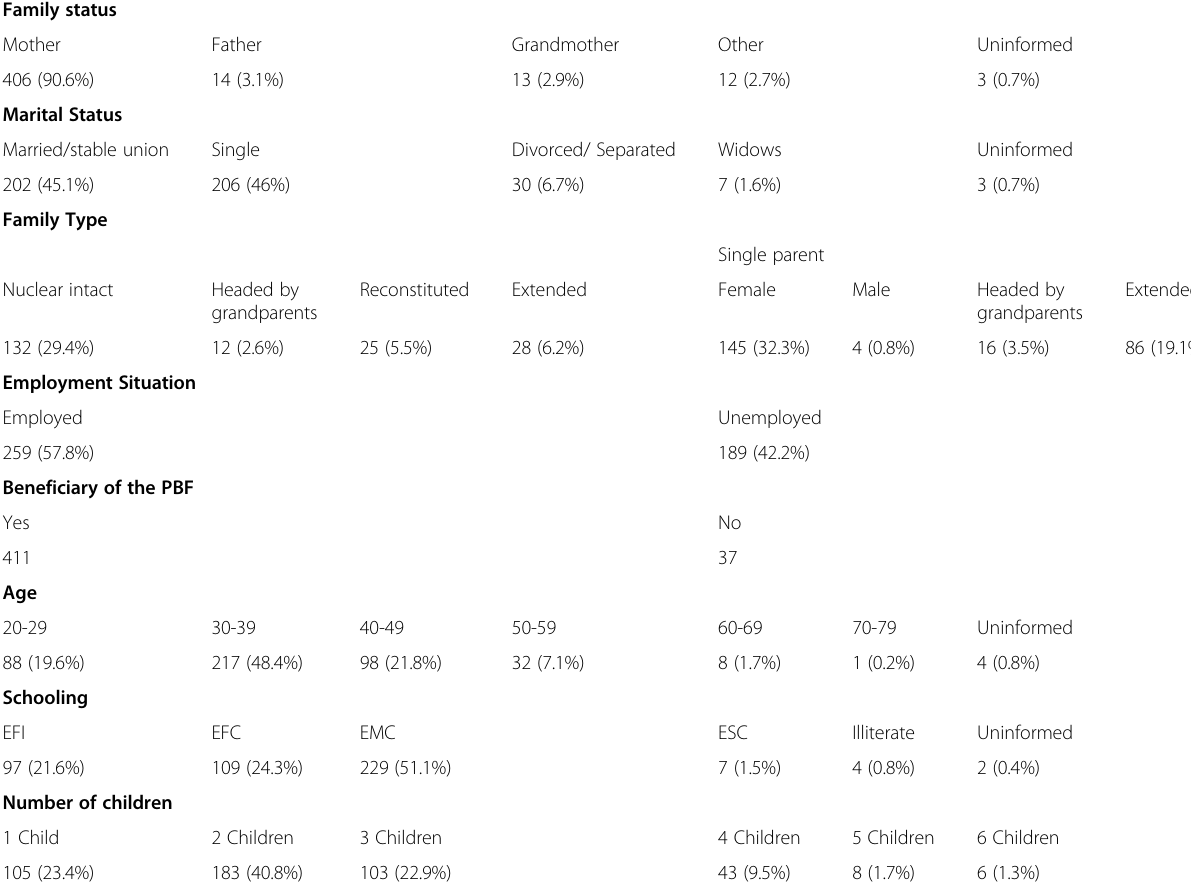
Table 2 Sociodemographic characteristics of poor families living in the municipality of Belém (PA) ( n = 448) Family